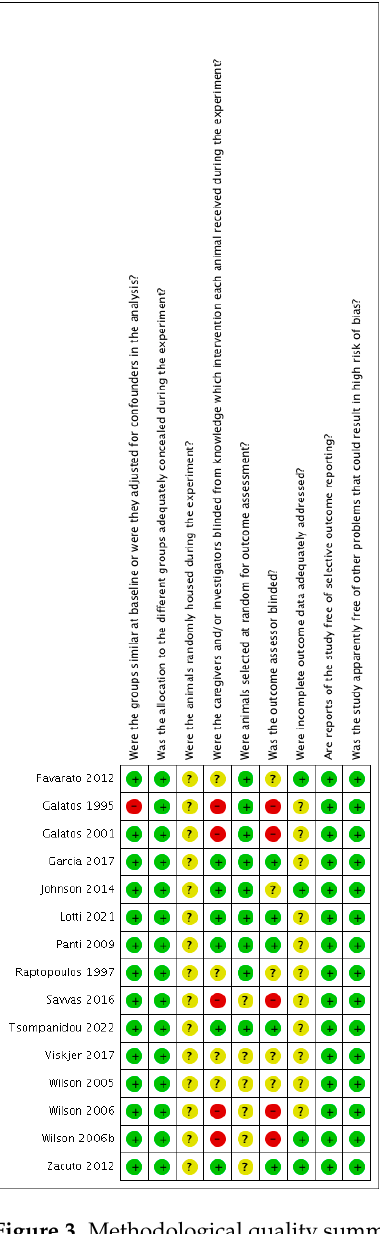
Figure 3. Methodological quality summary: review authors’ judgements about each methodological quality item for each included study. ?: unclear risk, − : high risk; +: low